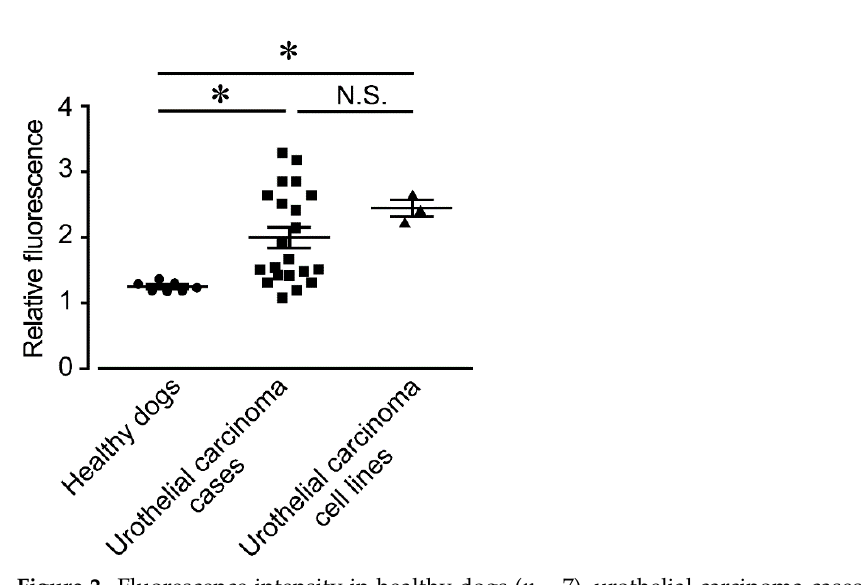
Figure 1. The top panel shows fluorescence microscopy images of urine-derived cells from healthy dogs, urothelial carcinoma cases (No. 2 and No. 5), and urothelial carcinoma cell lines (Sora, Love, TCCUB) when vehicles were added. No red fluorescence was observed in any of the cells. The lower panel shows the fluorescence microscopy image when 5-ALA was added. No red fluorescence is observed in urine-derived cells from healthy dogs. The urine-derived cells from case No. 5 showed clear red fluorescence. Weak red fluorescence was observed in urine-derived cells derived from case No. 2. Strong red fluorescence was observed in all three urothelial carcinoma cell lines: Sora, Love, and TCCUB. Bar = 50 μ m.